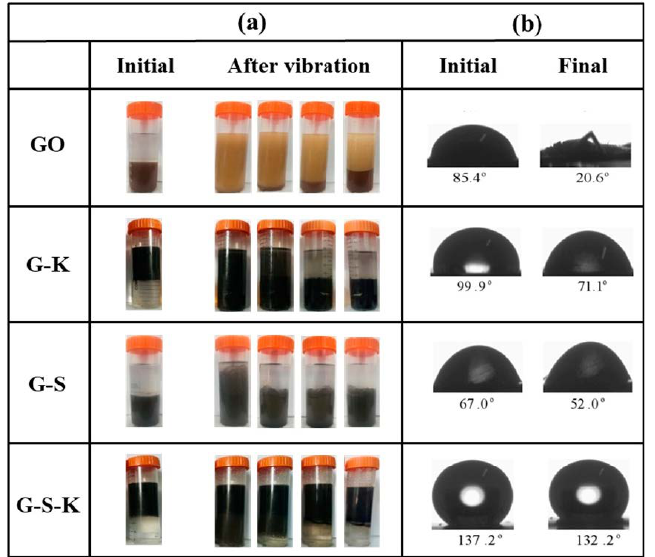
Figure 5. ( a ) Oil-water mixing experiment diagram and ( b ) contact angle of GO, G-K, G-S, and